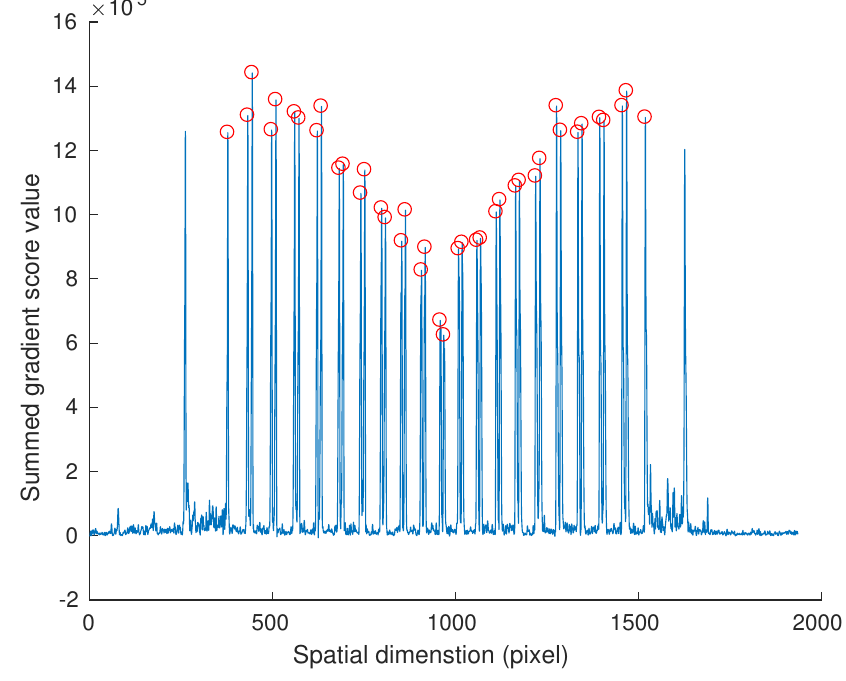
Figure 5. Estimation of camera observations points y i ( i = 1, · · · ,40 ) from a hyperspectral line-scan camera image. The blue line is the up-sampled and cubic spline interpolated gradient score value G ( j ) . The red circles are estimated camera observation point y i ( i = 1, · · · ,40 ) . The camera observation points are obtained by extracting the 42 highest peaks and excluding the first and last peaks along the spatial dimension. The first and last peaks correspond to the edges of the calibration